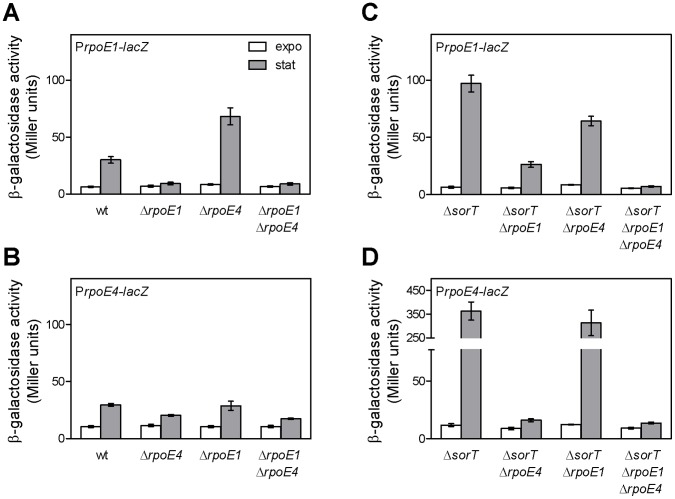
Expression of rpoE1 and rpoE4 at different growth phases and in various genetic backgrounds.Expression from the promoter of the rpoE1 (A, C) or rpoE4 (B, D) operon was estimated by measuring β-galactosidase activity driven from the chromosomal PrpoE1-lacZ fusion in strains CBT1183 (wt), CBT1185 (ΔrpoE1), CBT1191 (ΔrpoE4), (CBT1247 (ΔrpoE1 ΔrpoE4), CBT1315 (ΔsorT), CBT1350 (ΔsorT ΔrpoE1), CBT1354 (ΔsorT ΔrpoE4) and CBT1358 (ΔsorT ΔrpoE1 ΔrpoE4) or from the chromosomal PrpoE4-lacZ fusion in strains CBT1218 (wt), CBT1220 (ΔrpoE1), CBT1224 (ΔrpoE4), CBT1251 (ΔrpoE1 ΔrpoE4), CBT1317 (ΔsorT), CBT1356 (ΔsorT ΔrpoE4), CBT1352 (ΔsorT ΔrpoE1) and CBT1360 (ΔsorT ΔrpoE1 ΔrpoE4) grown in Vincent minimal medium with sodium succinate as carbon source either to exponential phase (OD600∼0.5; white bars) or stationary phase (∼24–30 h after the previous point; grey bars). The results shown are the means and standard errors of data from four to thirteen independent experiments.